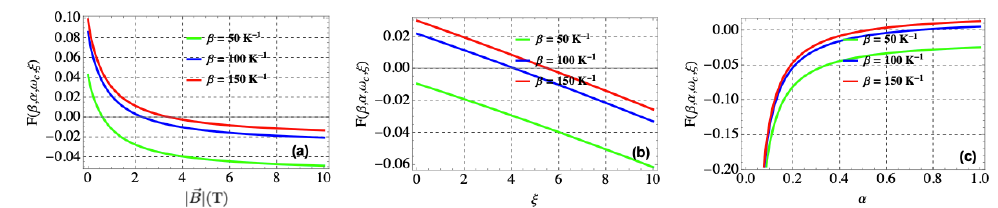
Figure 2. ( a ) Free energy F ( β ) as a function of: ( a ) | (cid:126) B | ( T ) for different values of β ; ( b ) ξ for same different values of β ; ( c ) α for different values of β . For all three plots, β = 50 k − 1 (green curve), 100 k − 1 (blue curve) and 150 k − 1 (red curve); all other parameters are the same as in Figure